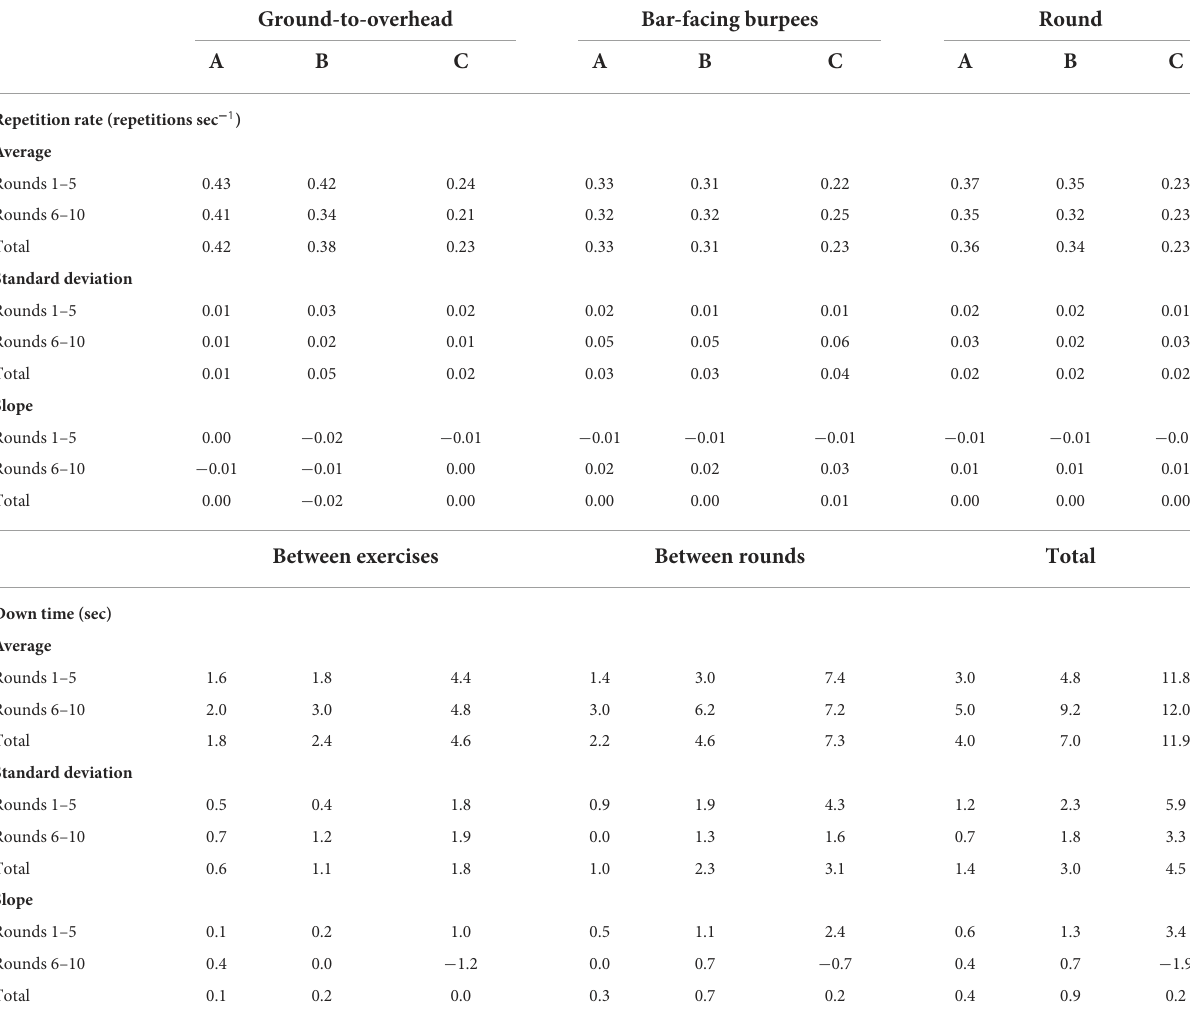
TABLE 4 Comparisons in workout and workout component completion rates between three athletes completing the first workout of the 2020 CrossFit ®